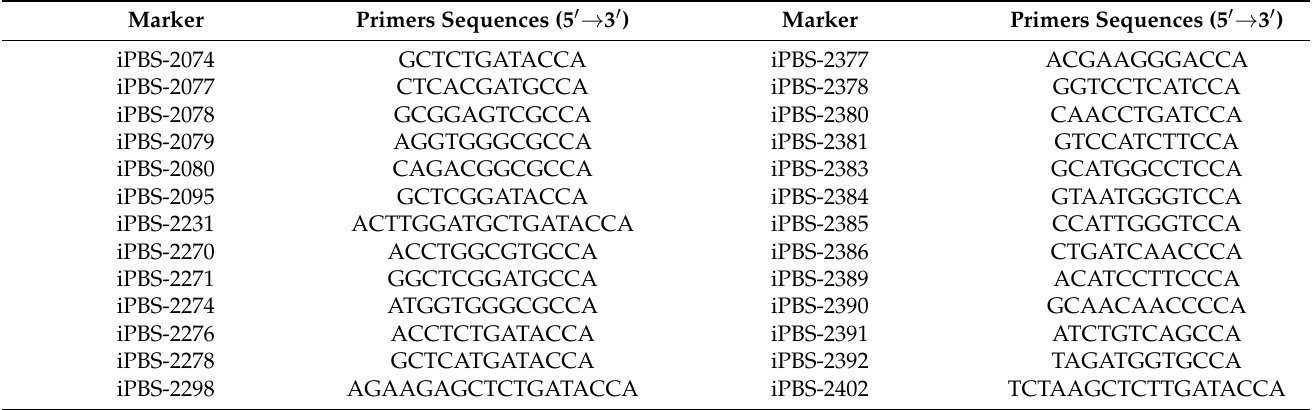
Table 2. List of 26 iPBS-retrotransposon primers with their sequence used to elucidate genetic diversity among 45 common bean